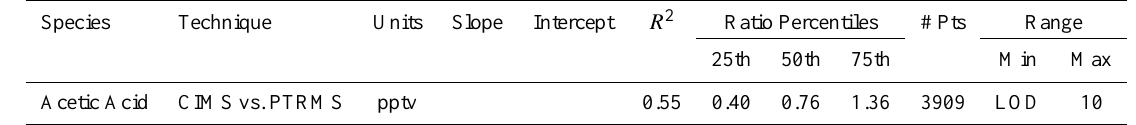
Table 5b. C-130 intra-platform comparison. Photochemical products. NOTE: Technique is listed as X vs. Y. Species